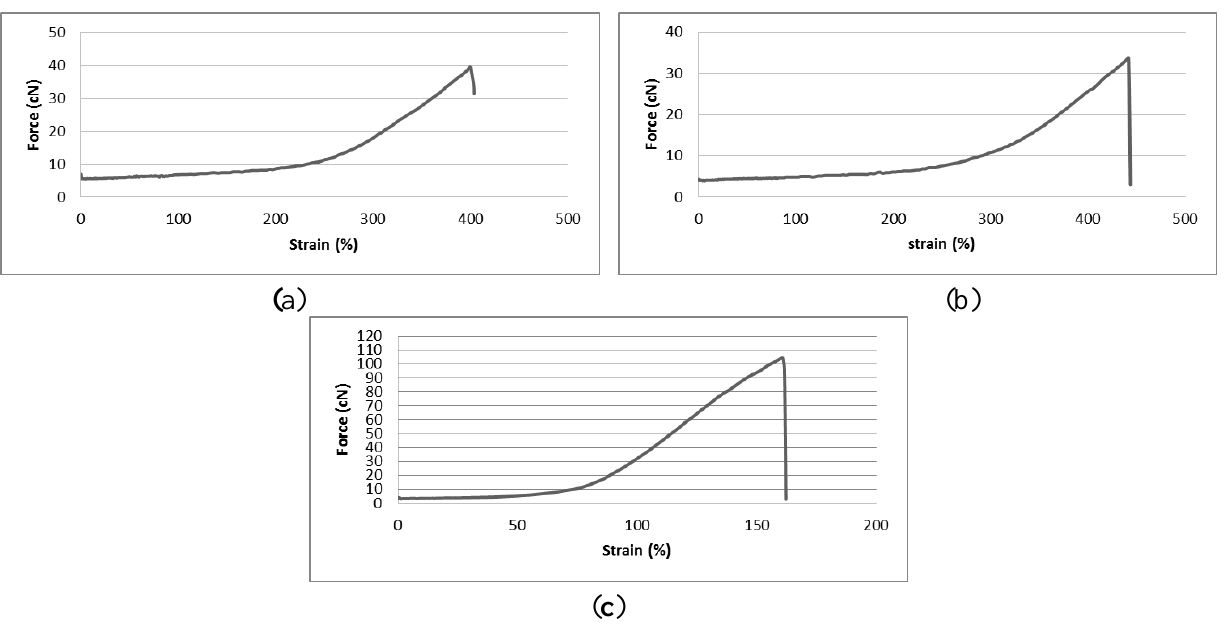
Figure 1. Force-strain graphs of three different gauges of elastomeric yarn. ( a ) Knitted structure with 800 dtex elastomeric yarn. ( b ) Knitted structure with 570 dtex elastomeric yarn. ( c ) Knitted structure with 156 dtex elastomeric